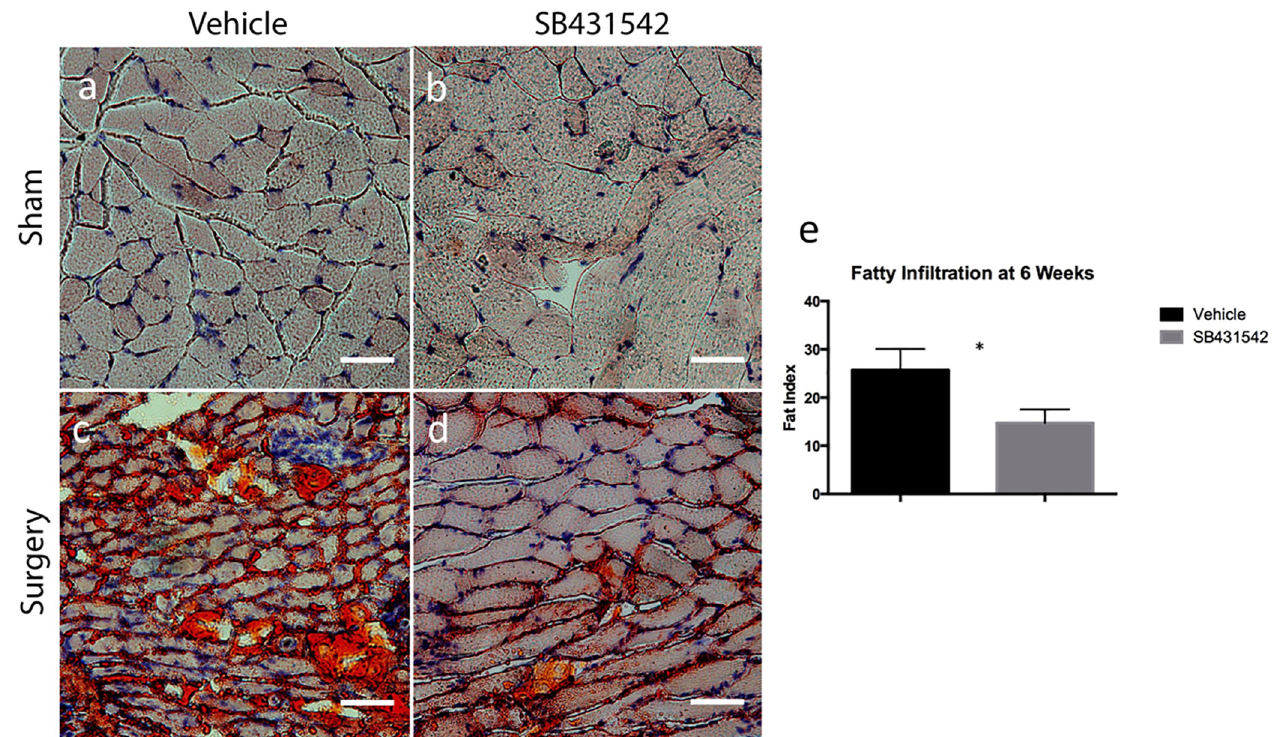
Fig 2. SB431542 reduces rotator cuff muscle fatty infiltration after injury. (a-d) Representative oil red-O stain of supraspinatus muscle sections at 6 weeks, scale bar = 50 μ m. (e) Quantification of injured muscle fat index indices at 6 weeks from 4 whole muscle sections/animal (N = 4/group) imaged at 5X magnification, * p <